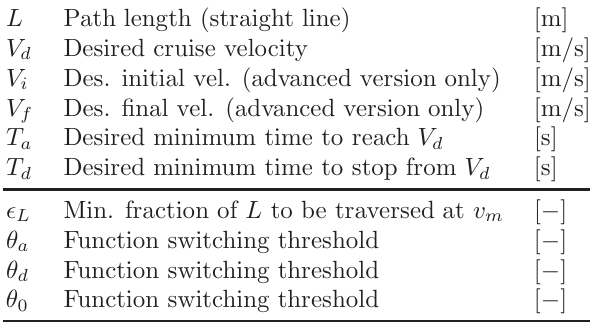
Table 1: Tuning parameters of the